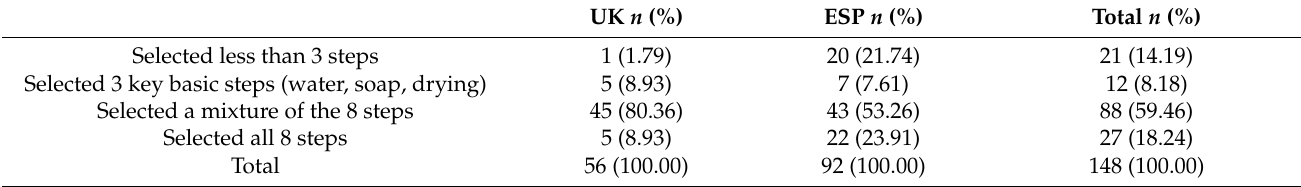
Table 10. Which of the following hand hygiene steps do you follow when washing your hands